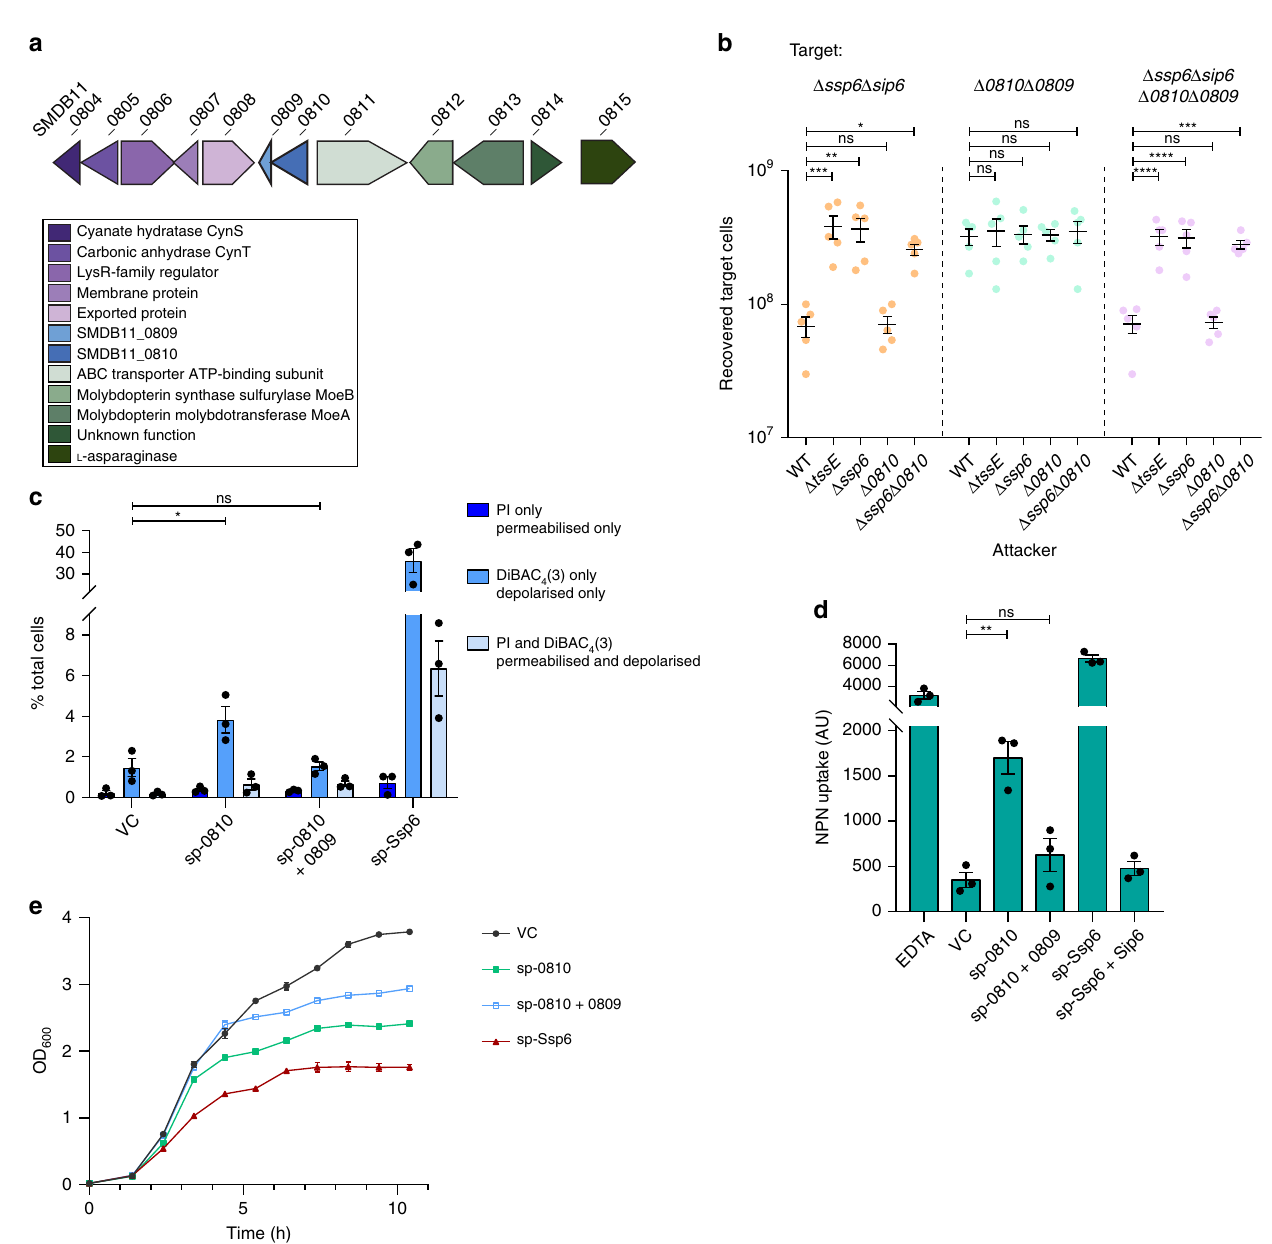
Fig. 7 SMDB11_0810 and SMDB11_0809 represent ‘ silent ’ homologues of the Ssp6-Sip6 effector-immunity pair. a Schematic representation of the genomic context of SMDB11_0810 and SMDB11_0809, with genomic identi fi ers (SMDB11_xxxx) provided above each gene and predicted protein functions in the box below. b Recovery of target strains of S. marcescens Db10, Δ ssp6 Δ sip6 , Δ SMDB11_0810-0809 ( Δ 0810 Δ 0809 ), and Δ ssp6 Δ sip6 Δ SMDB11_0810 - 0809 ( Δ ssp6 Δ sip6 Δ 0810 Δ 0809 ) when co-cultured with wild type (WT) or mutant ( Δ tssE , Δ ssp6 , Δ SMDB11_0810 and Δ ssp6 Δ SMDB11_0810 ) attacker